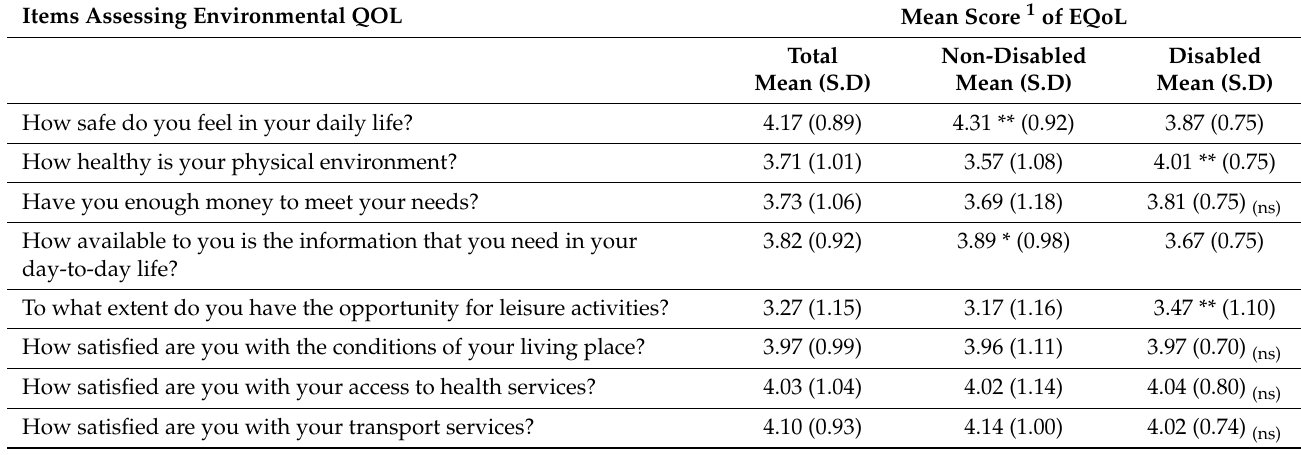
Table 2. Mean scores on EQoL in total sample and between individuals with and without disabili- ties ( t